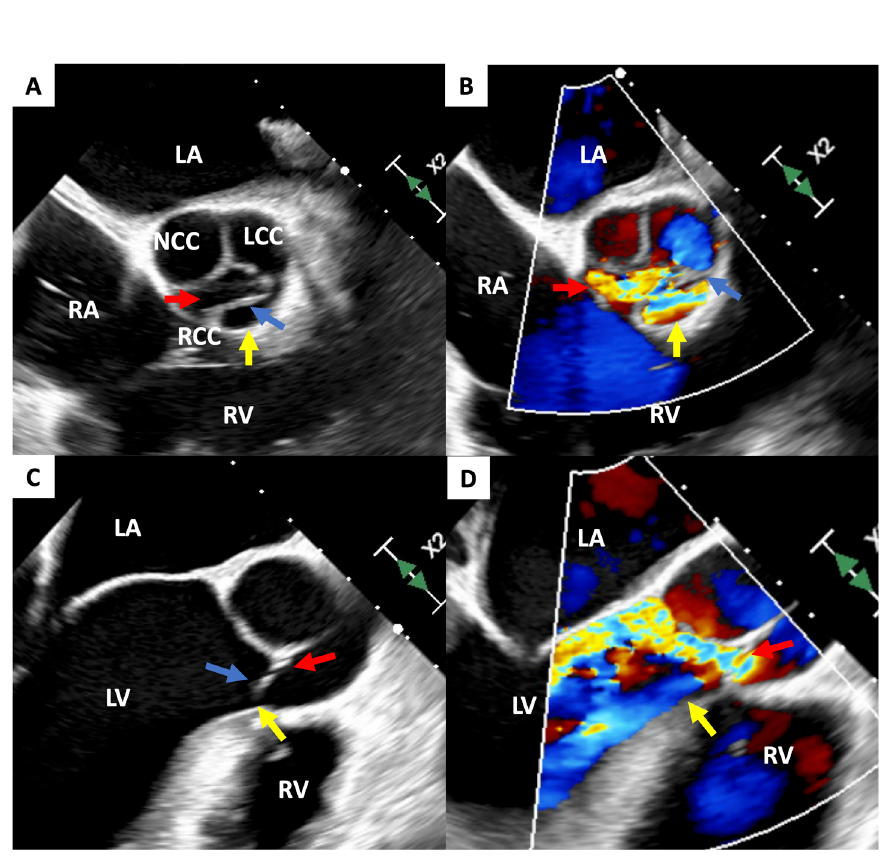
Figure 1. Transesophageal echocardiogram visualizing severe AR. ( A , B ): short-axis view, 51 degrees rotation; ( C ): long-axis view, 139 degrees rotation; and ( D ): long-axis view, 133 degrees rotation. Two